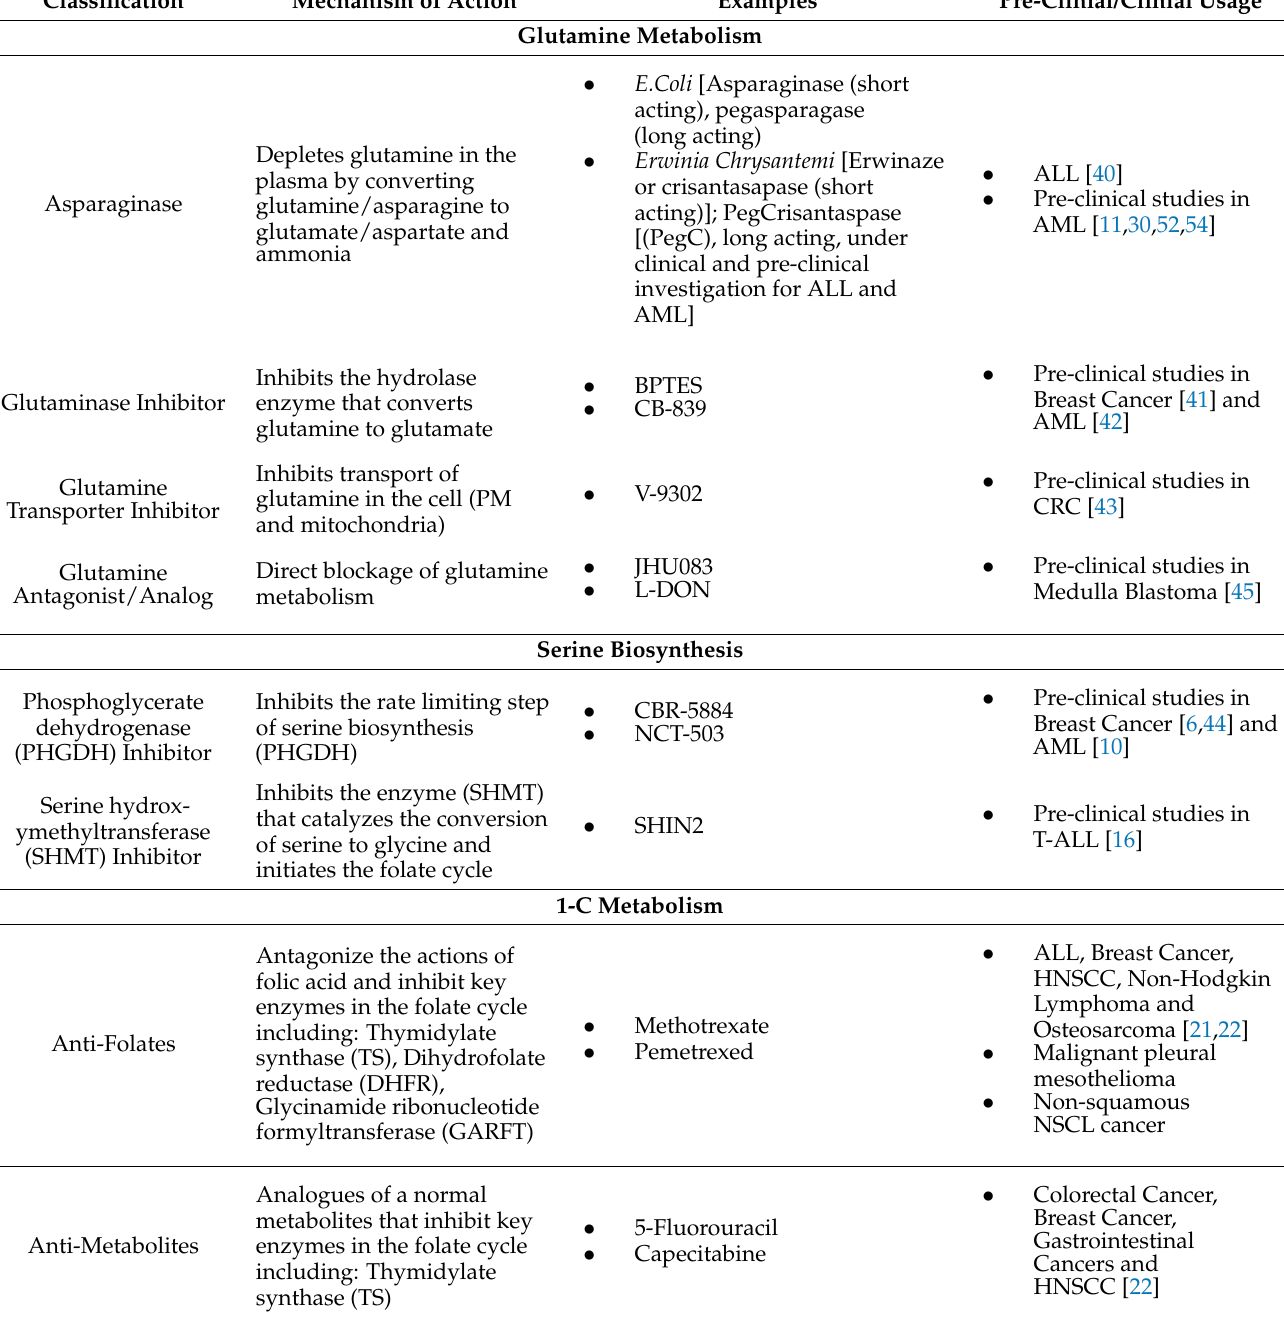
Table 1. Drugs Targeting Glutamine, Serine, and 1-C